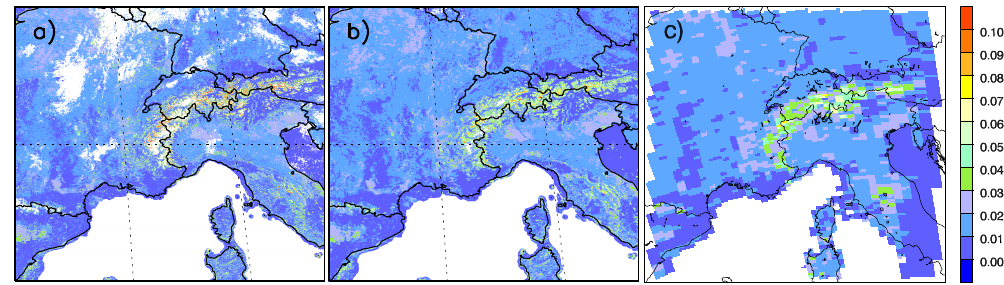
Fig. 2. Illustration of the processing of MODIS BRDF/albedo data sets for a single OMI orbit on 1 December 2006 over central Europe, for the coefficients f vol as an example. (a) Original f vol from MCD43B1, (b) after filling in missing values and (c) averaged over OMI pixels.